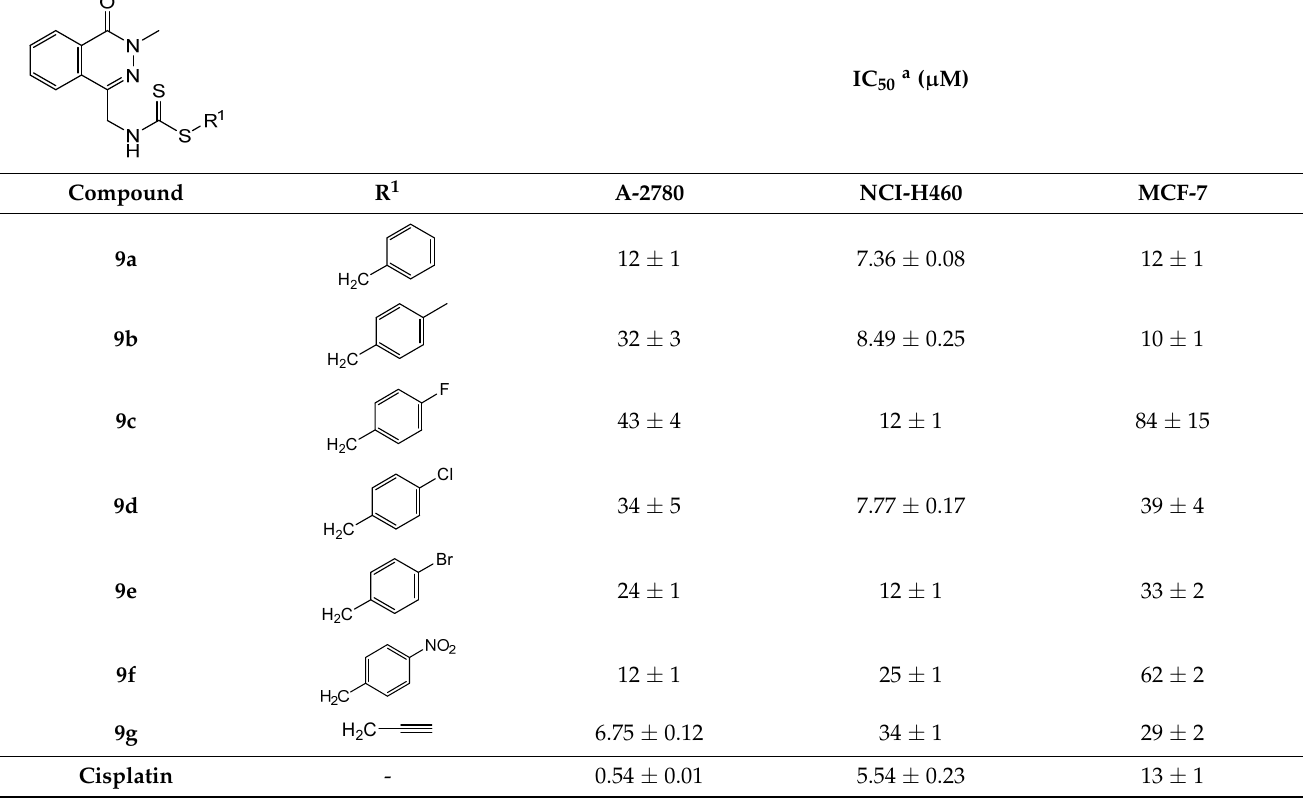
Table 2. Antiproliferative activity (IC 50 values) of phthalazinone-dithiocarbamate hybrid compounds 9a – g against A-2780, NCI-H460, and MCF-7 cell lines.